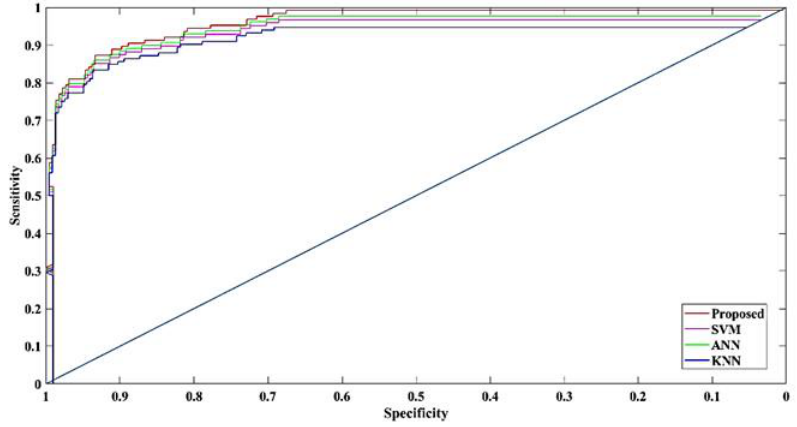
Figure 10. Comparison of AUC and ROC characteristics. Table 2. Confusion matrix of the proposed method.